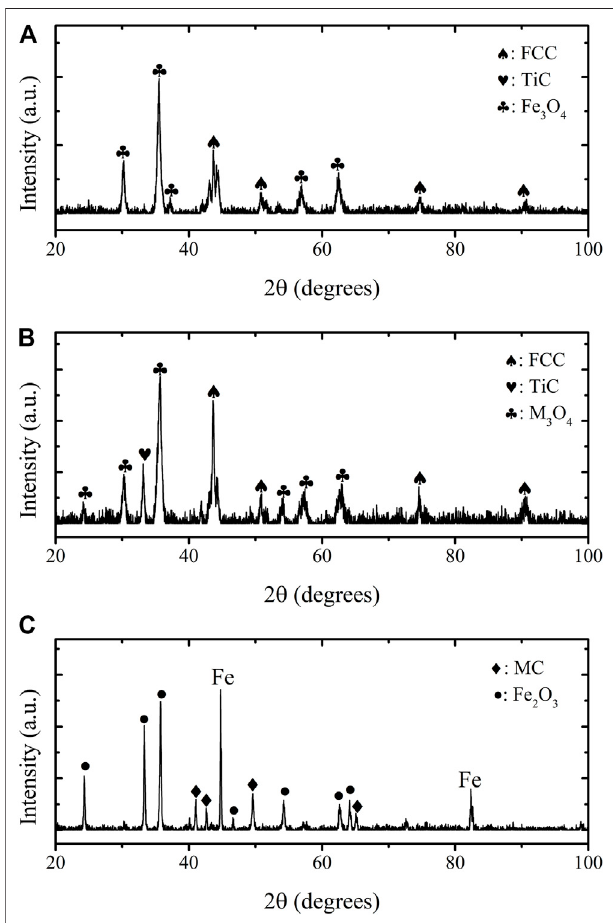
FIGURE 7 | XRD patterns of (A) TC02 alloy, (B) TC05 alloy, and (C) M2 steel after wear testing at 700 ° C.